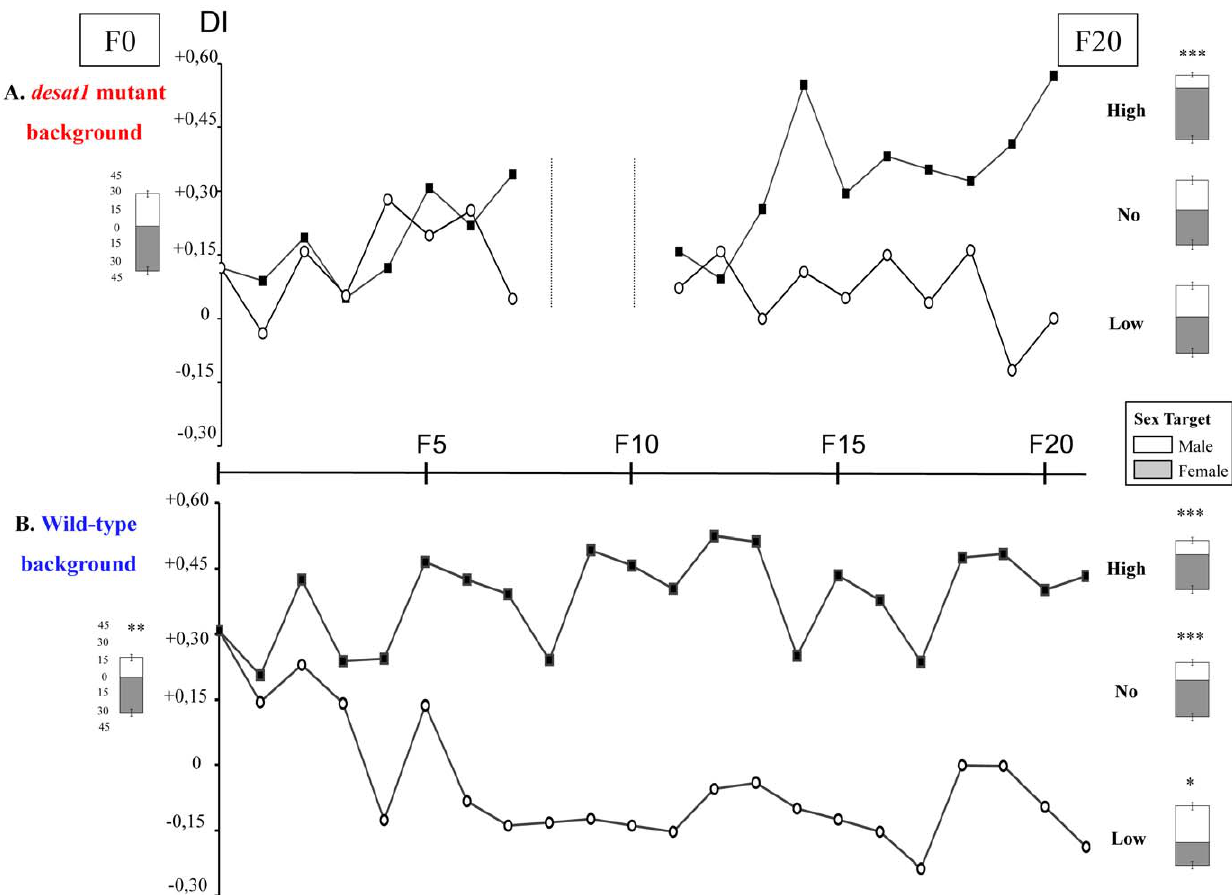
Figure 1. Selection for male discrimination of sex pheromones in two genetic backgrounds. Experimental selection was carried out in a desat1 mutant background (A) and in a wild-type background (B). At each generation, and until generation 21 (F21), single tester males were selected for their ability to discriminate wild-type male and female targets simultaneously presented. Histograms indicate the mean ( 6 sem) of the courtship index directed towards target males (empty bars, CIm) and target females (filled bars; CIf). CIm and CIf are shown for both parental strains ( desat1 and wild-type; left) and for selected lines with high (‘‘High’’; right) and low discrimination (‘‘Low’’) and for unselected lines (‘‘No’’). Data shown for each generation represent the discrimination index (DI=[CIf 2 CIm]/[CIf + CIm]) which was calculated on ‘‘High’’ lines (filled squares), and ‘‘Low’’ lines (empty circles). The level of significance of discrimination, assayed with a paired t -test is indicated above bars: *** P , 0.001; ** P , 0.001; * P , 0.05. N $ 60.